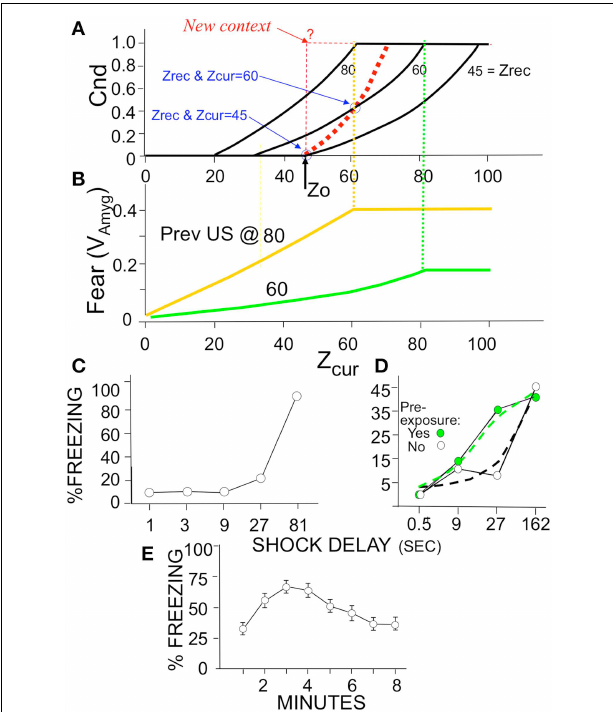
FIGURE 6 | Expected Cnd and Fear ( V Amyg ) as a function of Z cur and Z rec with corresponding animal data. (A) Conditionability, as explained in Results. The black curves are for sessions entered with the specified Z rec values. For all curves Expected Cnd = linsig [ B Rep ( Expected Z com |Z cur , Z rec ) |B old , B add ]. The bold dashed red curve is for a session in which representation creation occurs at Z 0 ; it is calculated in the same way as the other curves but taking into account that Z rec increases with each successive sample subsequent to representation creation; thus Z rec = Z cur (as indicated for the two circled values). The thin dashed red line corresponds to the empirically untenable possibility, discussed in the text, that Cnd rises to its maximum value as soon as a representation is created. (B) Fear as a function of Z cur for automata previously conditioned in a new context with a US after 60 or 80-samples and the session then terminated. Vertical dashed lines indicate that Cnd and Fear expression plateau at the same number of attributes sampled. (C–E) Empirical demonstrations of effects produced by BACON (C) Immediate shock deficit (Data from Fanselow, 1990, Figure 2 ). (D) Shortening of deficit due to pre-exposure (Redrawn data from Fanselow, 1990, Figure 3 ; dashed lines indicate an interpretation consistent with simulation data). (E) Gradual onset of freezing at start of session (Data from Wiltgen et al., 2006). Decline is due to extinction, which automaton does not